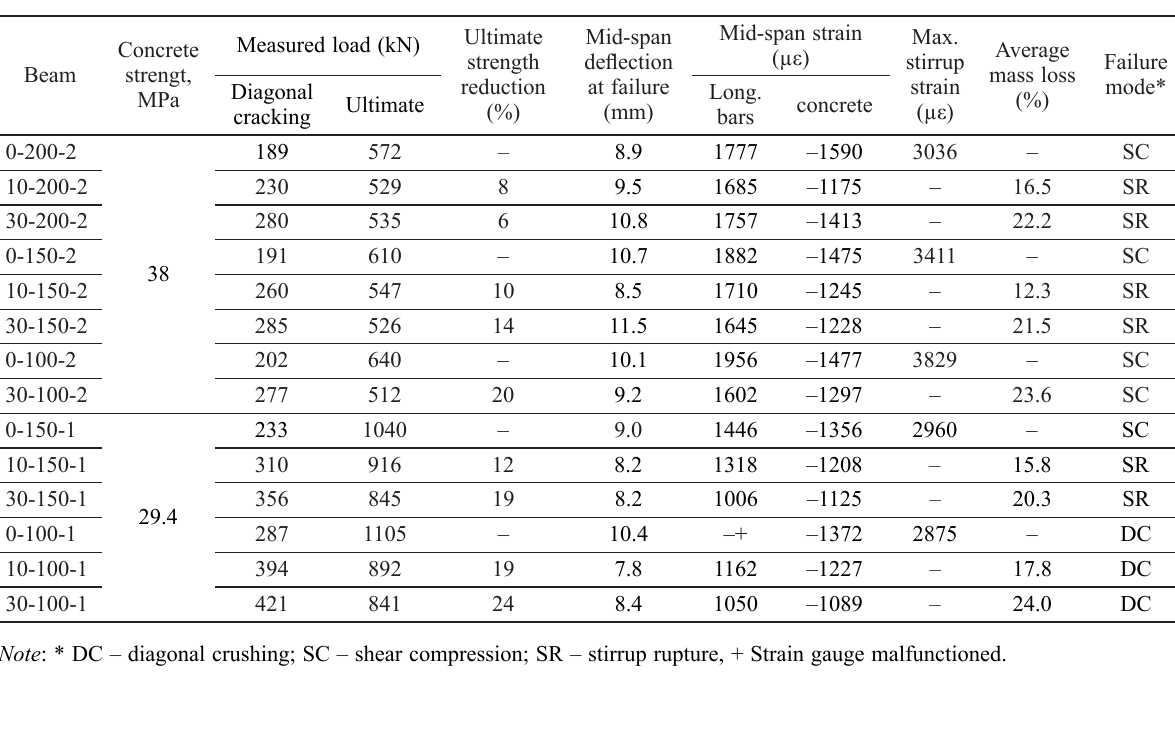
Table 3. Summary of test results